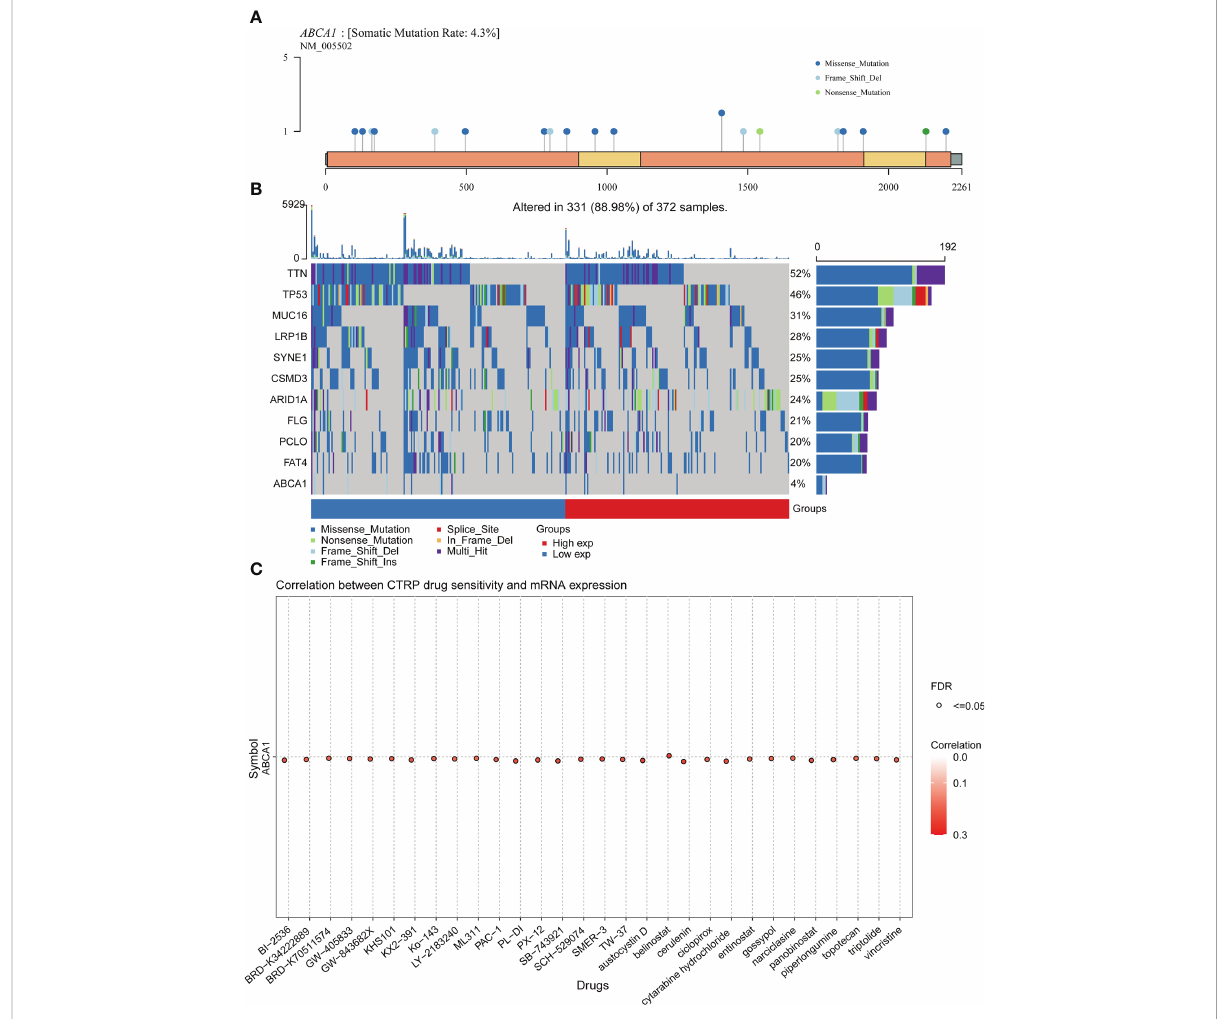
FIGURE 11 Mutation analysis and drug sensitivity analysis of ABCA1 in STAD. (A) Lollipop plot of ABCA1 mutation distribution in the genome. (B) A waterfall map of the somatic mutation landscape in the TCGA-STAD cohort, including the top 10 mutation-frequency genes and ABCA1. (C) Correlation analysis of ABCA1 mRNA expression and drug sensitivity in pan-cancer using the GSCA